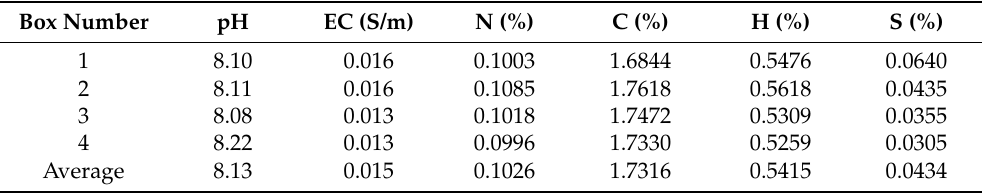
Table 3. Initial soil attributes.